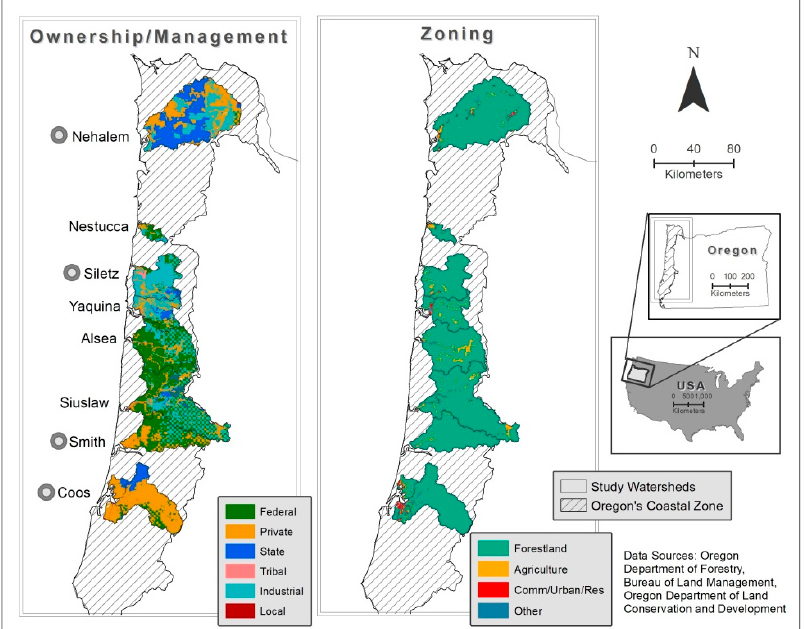
Figure 1. Location of eight watershed areas within the Oregon coastal zone where three species of bivalves were collected for biomonitoring. Colors indicate key land use (ownership and zoning attributes of study watersheds). Circles indicate a subset of watershed areas where passive water sampling was also conducted. Abbreviations: Res/Comm/Indust = zoned for residential, commercial, and industrial uses.